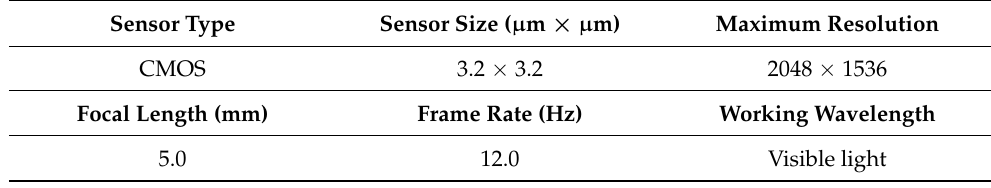
Table 6. The basic parameters of visible-light camera in our experimental